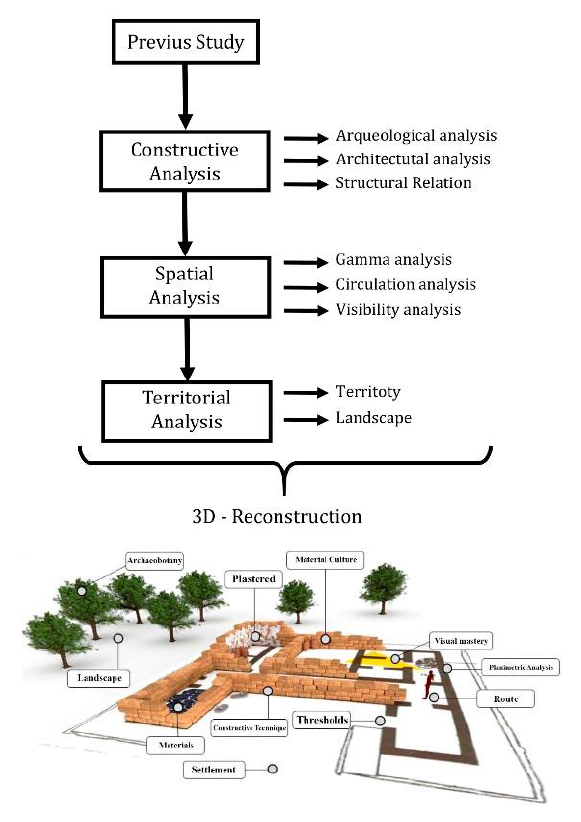
Figure 8. Flow diagram of work on the Building Tartessos project: a constructive, spatial, and territorial analysis of an architectural model in the central Guadiana